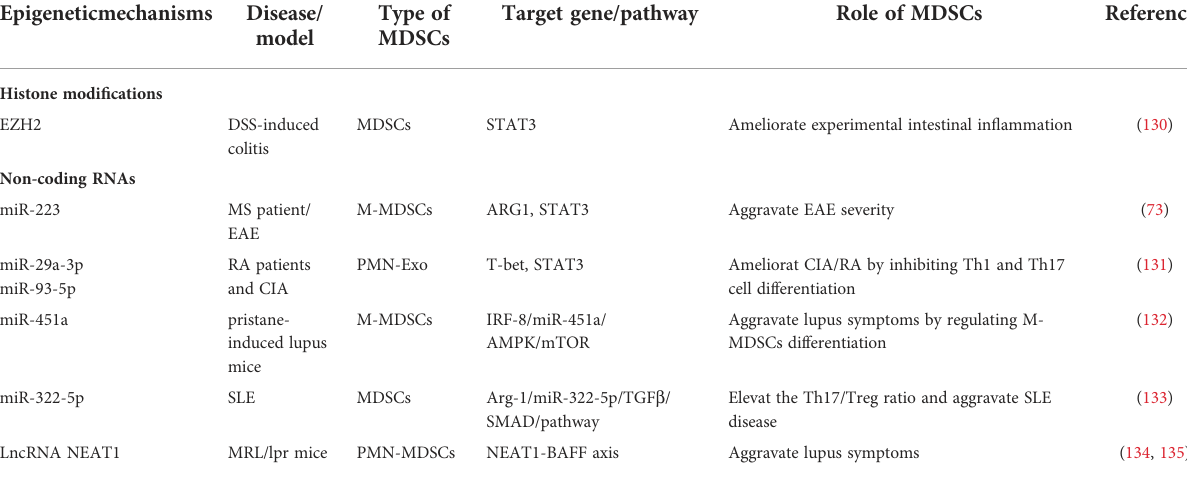
TABLE 4 Epigenetic mechanisms affecting the role of MDSCs in different autoimmune diseases.